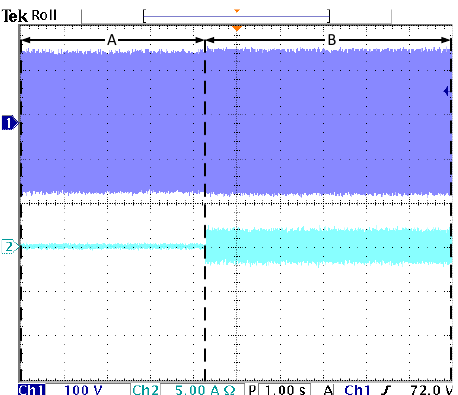
Figure 17. System injecting current. A: V N = 113 V RMS and B: V N = 114.6 V RMS .